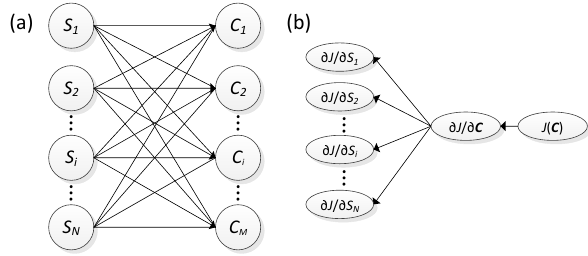
Figure 3. Schematic diagrams of the atmospheric chemistry for- ward (a) and adjoint (b) models. S 1 ,S 2 ,...,S n ,...,S N are emission sources of different sectors, or of different species, at different lo- cations, etc., and S is the emission vector; C 1 ,C 2 ,...,C m ,...,C M are pollutant concentrations at different sites, or of different species, and C is the concentration